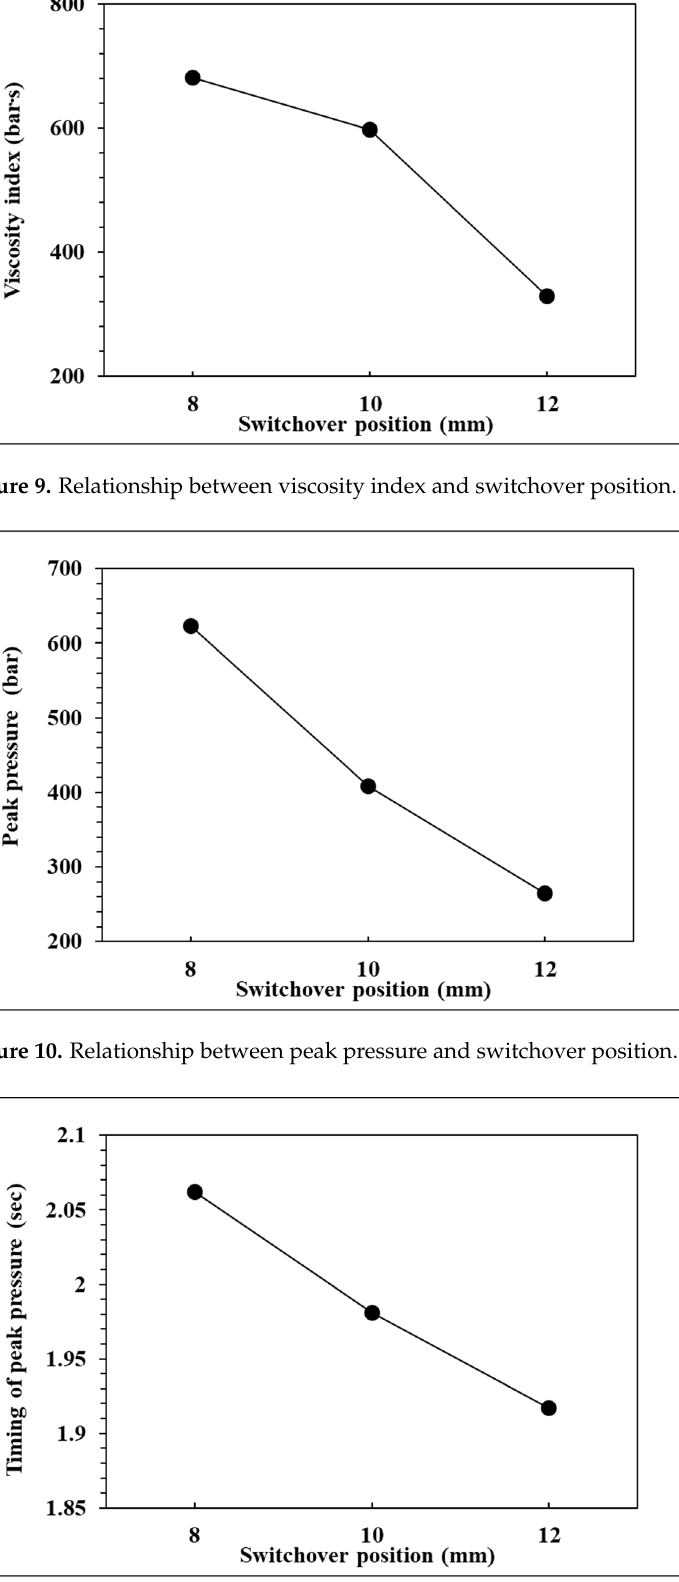
Figure 12. Relationship between part weight and switchover position . 4.2. Results of Single Factor Experiment of Injection Speed To observe the influence of injection speed on pressure curve characteristics and part weight, the effects of the single factor change of the injection speed were compared by the three groups of experiments, respectively, injection speed in 70%, 50%, and 30%. The relationships are shown in Figures 13–16. At the setting of high injection speed, the filling time is relatively shorter than the setting of low injection speed. The viscosity index which integrates pressure curve over time is relatively smaller at the setting of high injection speed according to the filling time. A large injection pressure is required to push the injection speed to the set value of the injection machine, so the peak pressure of the nozzle is relatively bigger at the setting of high injection speed. The faster the injection speed is, the greater the resistance of the melt is, resulting in the decrease of product weight. Figure 16 displays that the product weight is the lightest when the injection speed is 70%. The experiment results show that the injection speed has the same trend with respect to the viscosity index, peak pressure, timing of peak pressure and the product weight.